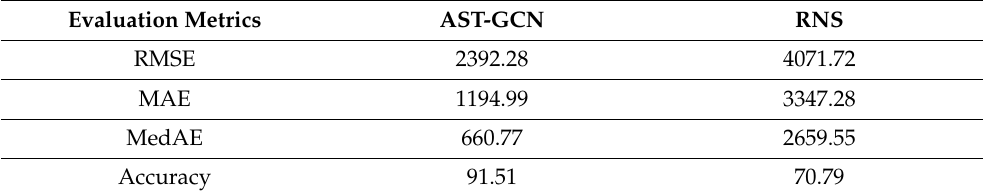
Table 4. Performance comparison of different models for well pattern production forecasting.